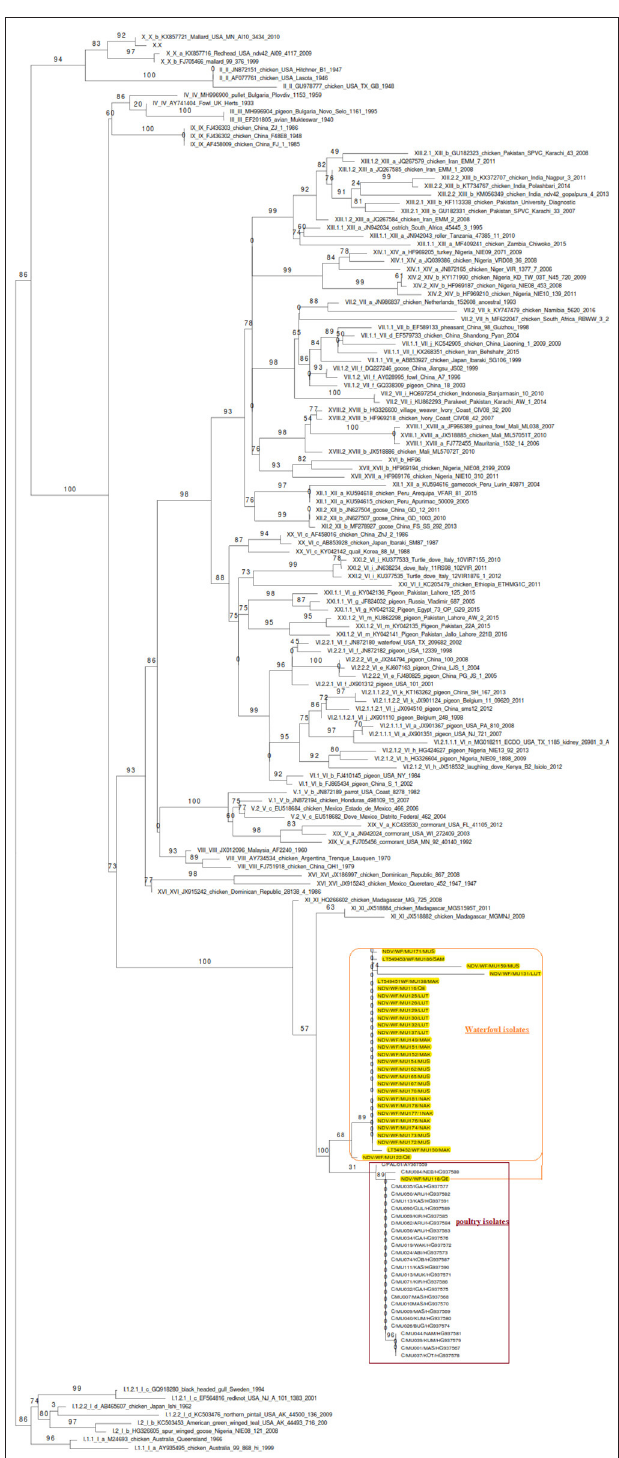
FIGURE 1 | Molecular phylogenetic analysis based on the nucleotide sequences of the F gene of ND viruses of class II by neighbor-joining method. The inferred ancestral F gene sequences of the Ugandan AAvV-1 isolates from waterfowl, poultry, and known vaccine strains based on the Tamura-Nei model using the bootstrap consensus of 1,000 replicates. AAvV-1